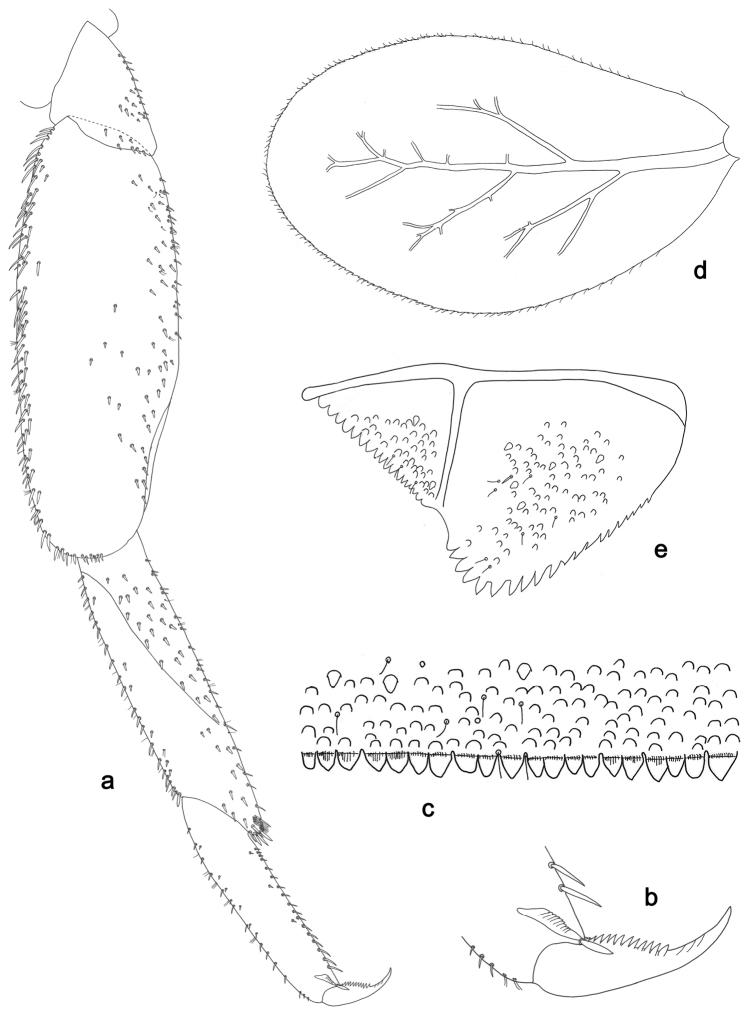
Labiobaetisaltus sp. n., larva morphology: aForelegb Fore claw cTergum IV d Gill IV eParaproct.